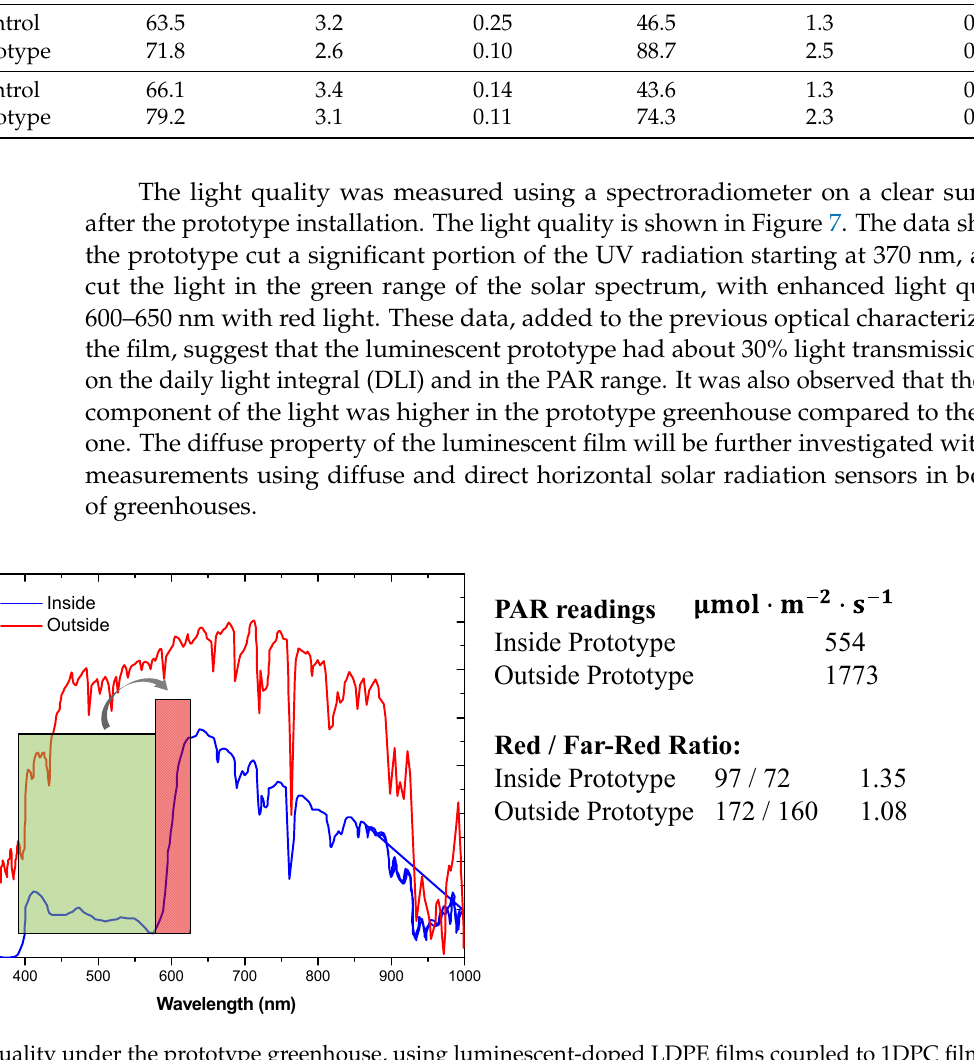
Table 3. Lettuce fresh and dry weight and leaf area comparison.